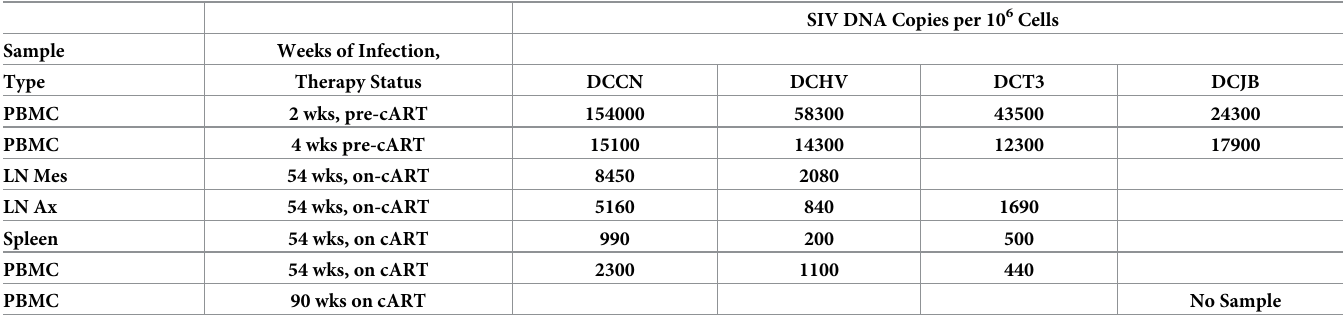
Table 5. Levels of SIV DNA in samples taken from infected macaques.